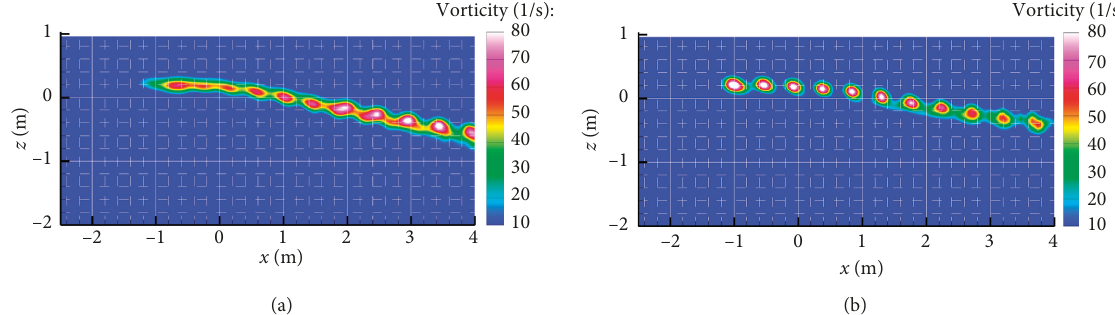
Figure 14: Predicted wake vorticity contour of ECR with 4 ∘ pre-index angle over the longitudinal planes. (a) Plane at y � 0.6 R on the advancing side; (b) Plane at y � − 0.7 R on the retreating